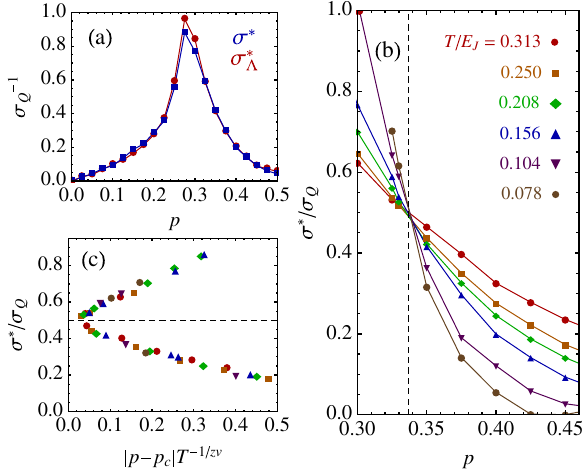
FIG. 6. (a) Comparison of two methods for obtaining the low- frequency conductivity near the SIT at T=E J ¼ 0 . 156 , with σ (cid:1) from the integrated spectral weight in Eq. (C3) and σ (cid:1) Λ from the current correlator Λ xx at imaginary time τ ¼ β = 2 (see the text). (b) Plot of σ (cid:1) ð T ; p Þ as a function of the disorder p at various temperatures. The various curves cross at the critical disorder strength p c at which σ (cid:1) is T independent with the critical value σ (cid:1) ≈ 0 . 5 σ σ (cid:1) ð T ; p Þ data with p ¼ Q . (c) Scaling collapse of the c 0 . 337 and z ν ¼ 0 . 96 , consistent with Fig. σ (cid:1)